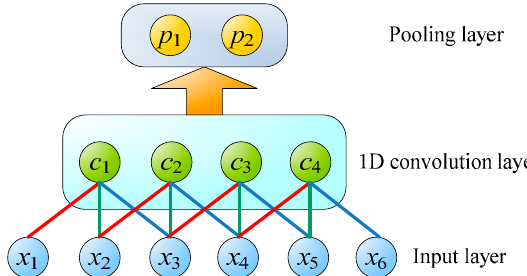
Figure 2. The one-dimensional (1D) convolution and pooling layer.